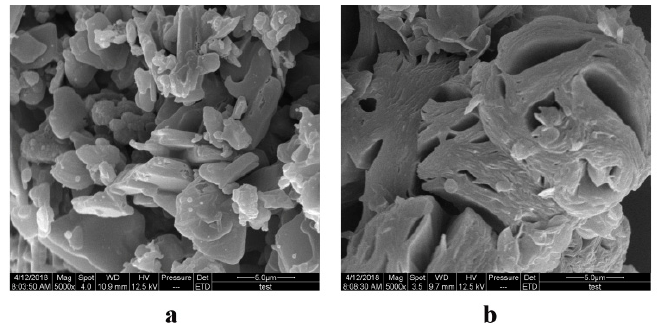
Figure 3. Scanning electron microscopy (SEM) images of the samples: ( a ) SEM image of free HK; ( b ) SEM image of the HK–PLX (1:4) SD.